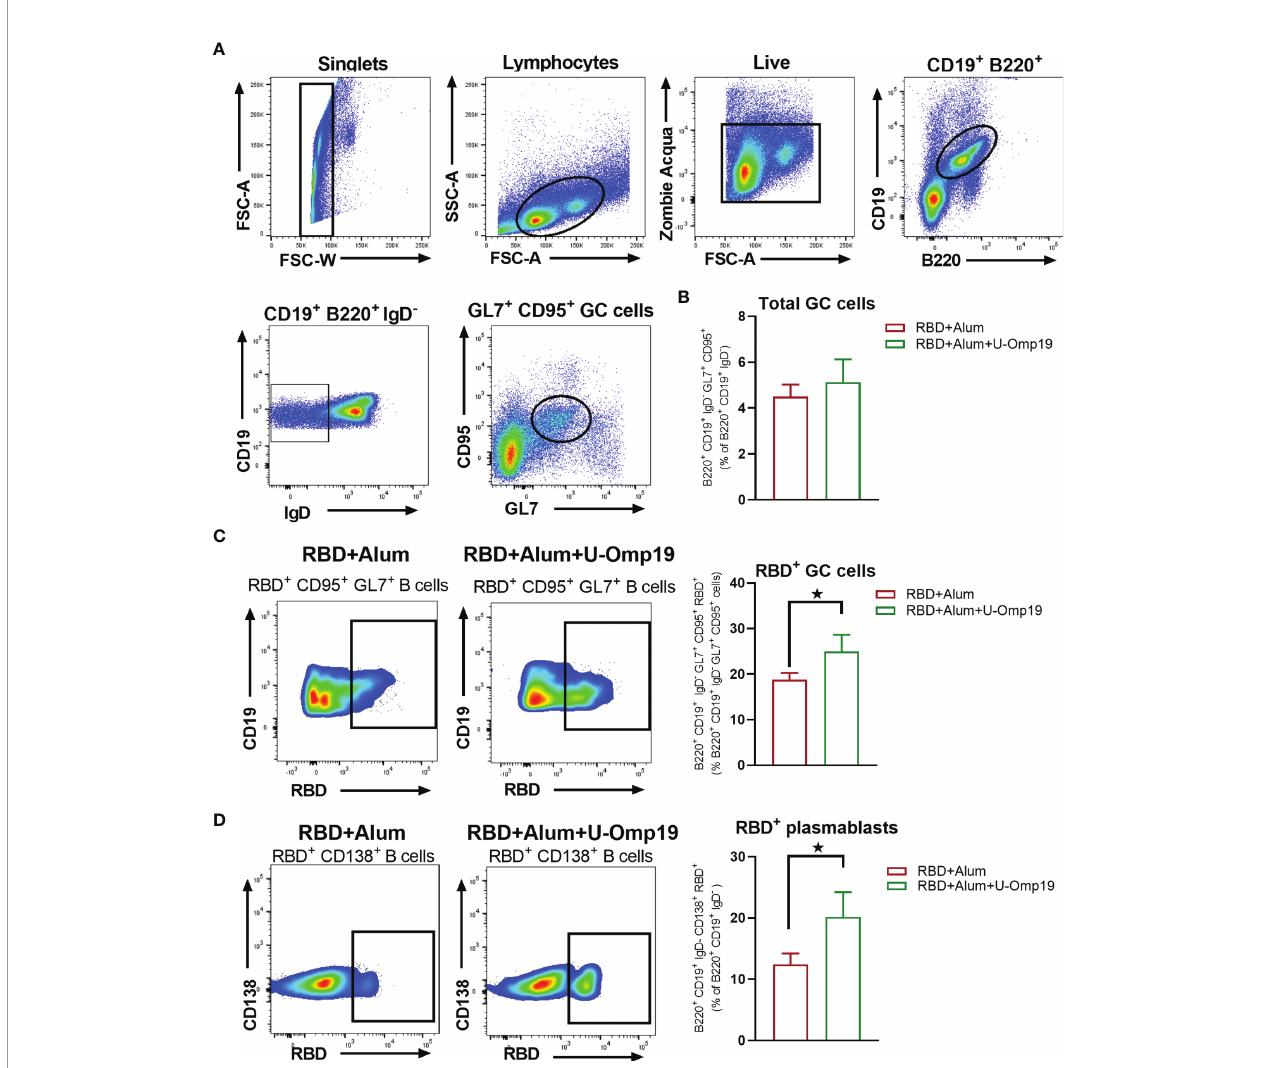
FIGURE 8 | U-Omp19 as adjuvant increases RBD speci fi c germinal center B cells and plasmablasts. Mice were vaccinated as described in Figure 7 . Flow cytometry analysis of different B-cell populations at spleen of vaccinated mice were performed using anti-CD19, anti-B220, anti-IgD, anti-CD138, anti-GL7, and anti- CD95 antibodies. Speci fi c cells were determined by binding to fl uorescent RBD. Gating strategy is shown in Panel (A) . (B) Results are presented as percentage of total GC cells (B220 + CD19 + IgD − GL7 + CD95 + ). Bars are means ± SEM. (C) Dot plots for each group are shown (right), and results are presented as percentage of RBD-speci fi c GC cells (B220 + CD19 + IgD − GL7 + CD95 + RBD + ). Bars are means ± SEM. * p < 0.05. t-test. (D) Dot plots for each group are shown (right), and results are presented as percentage of RBD-speci fi c plasmablasts (B220 + CD19 + IgD − CD138 + RBD + ). Bars are means ± SEM. * p < 0.05. t-test. Results are representative of two independent